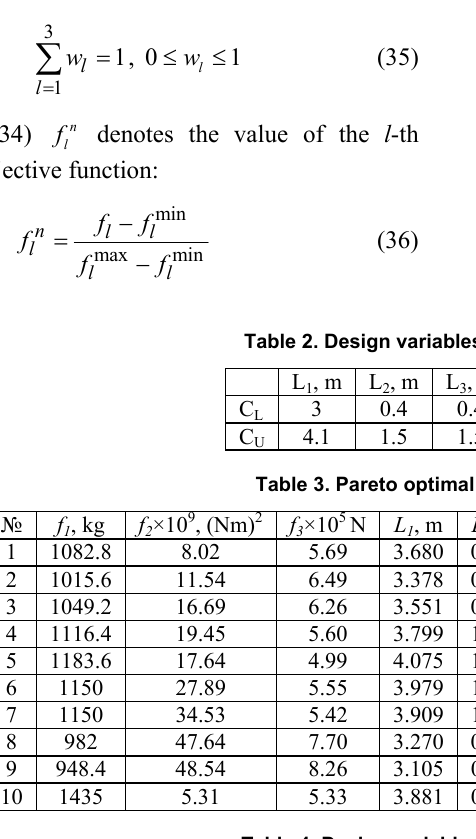
Table 4. Design variables bounds for Stage II